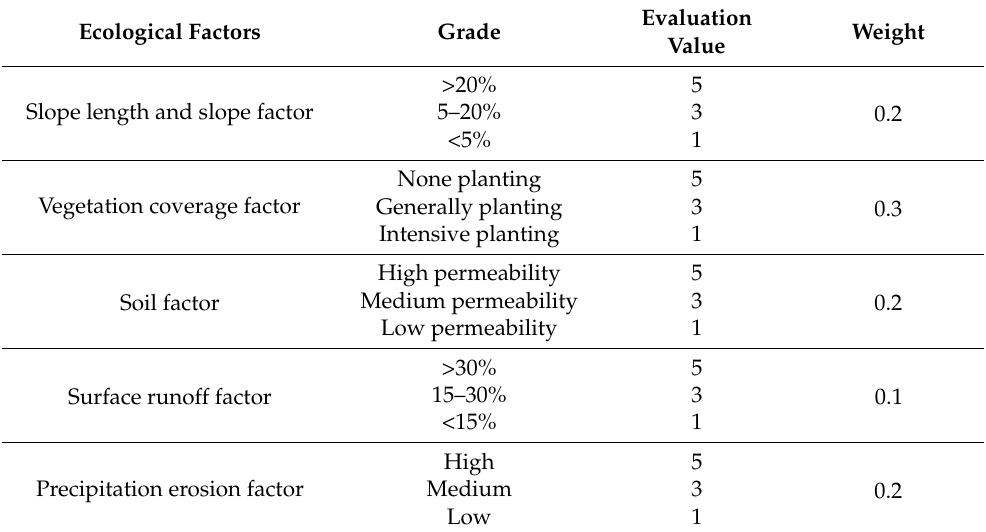
Precipitation erosion factor